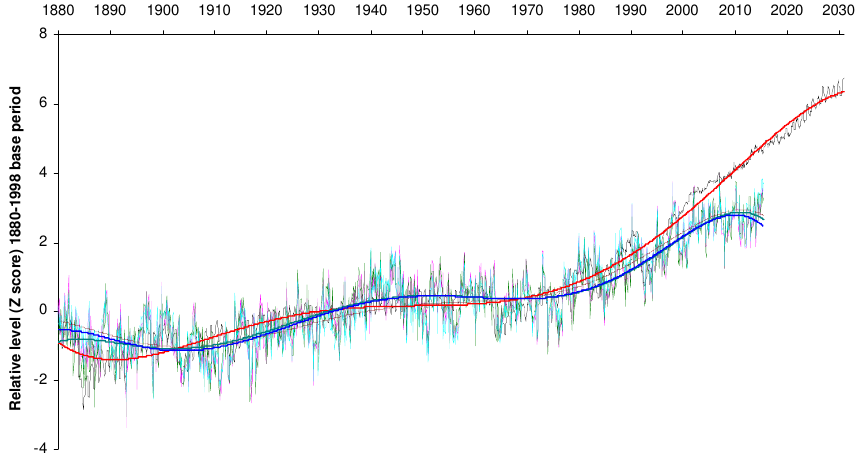
Figure 1. Monthly data, Z -scored to aid visual comparison (see Sect. 1). To show their core trends for illustrative purposes, the four series are fitted with sixth-order polynomials. Shown are: the output of an IPCC mid-range scenario model (CMIP5, RCP4.5 scenario) run for the IPPC fifth assessment report (IPCC, 2014) (black curve)(polynomial fit (pn): red curve). Global surface temperature data sets: HadCRUT4 (purple curve) (pn: blue curve); Cowtan and Way (2014) (green curve) (pn: light green curve); Karl et al. (2015) (aquamarine curve) (pn: brown